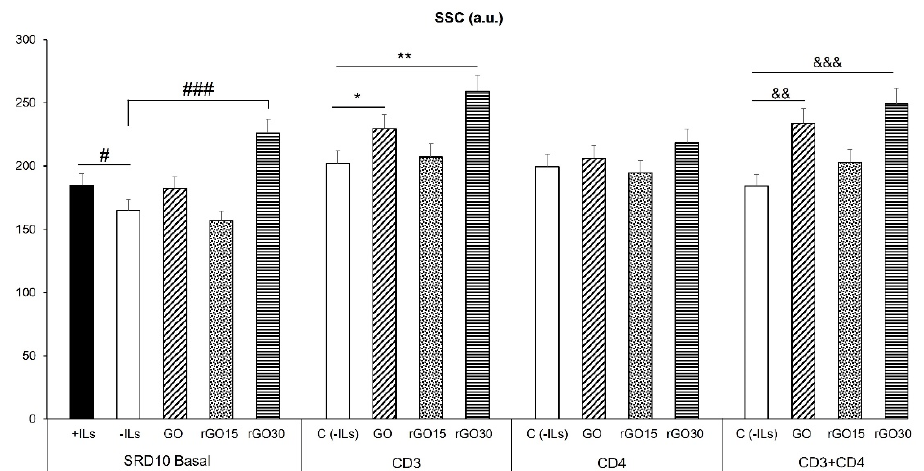
Figure 3. Effect of GO, rGO15 and rGO30 on the complexity of the CD4 + Th2 SR.D10 cell line after 24 h of treatment with 5 µg/mL of these nanostructures, evaluated by flow cytometry analyzing 90 ◦ light scatter (side scatter, SSC) under basal and activated conditions. Statistical significance: # p < 0.05 (compared to positive control cells without material cultured in the presence of ILs); ### p < 0.005 (compared to control cells without material cultured in the absence of ILs); * p < 0.05, ** p < 0.01 (comparison between nanostructures to control activated through CD3); && p < 0.01, &&& p < 0.005 (comparison between nanostructures to control activated through CD3 and CD4).